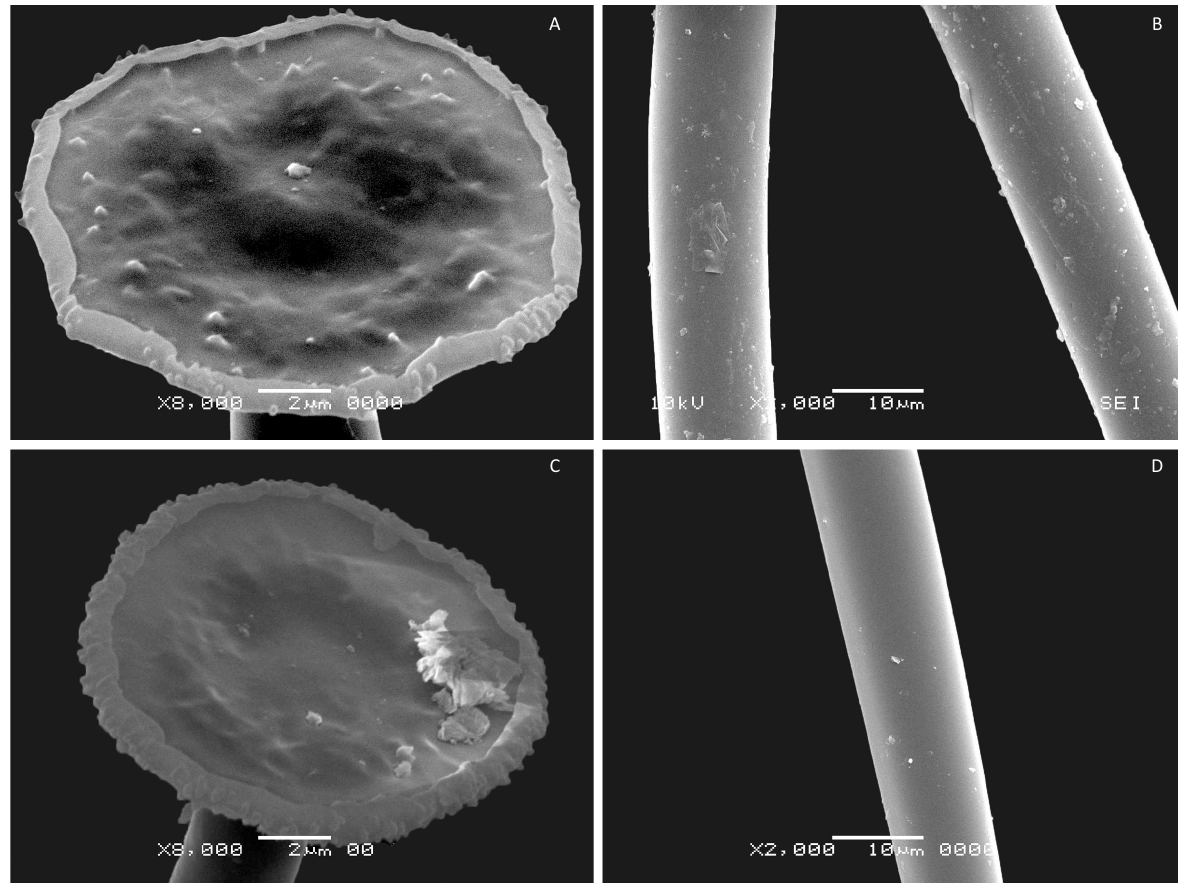
Image 4. Close-ups of upper rotules of gemmuloscleres and surface of megascleres. A - Upper rotule of gemmulosclere of T. latouchiana ; B - Megascleres of T. latouchiana showing smooth surface; C - Upper rotule of gemmulosclere of T. latouchiana sinensis ; D - Smooth surface of megasclere of T. latouchiana sinensis . © H.V. Ghate, Shriraj S. Jakhalekar &